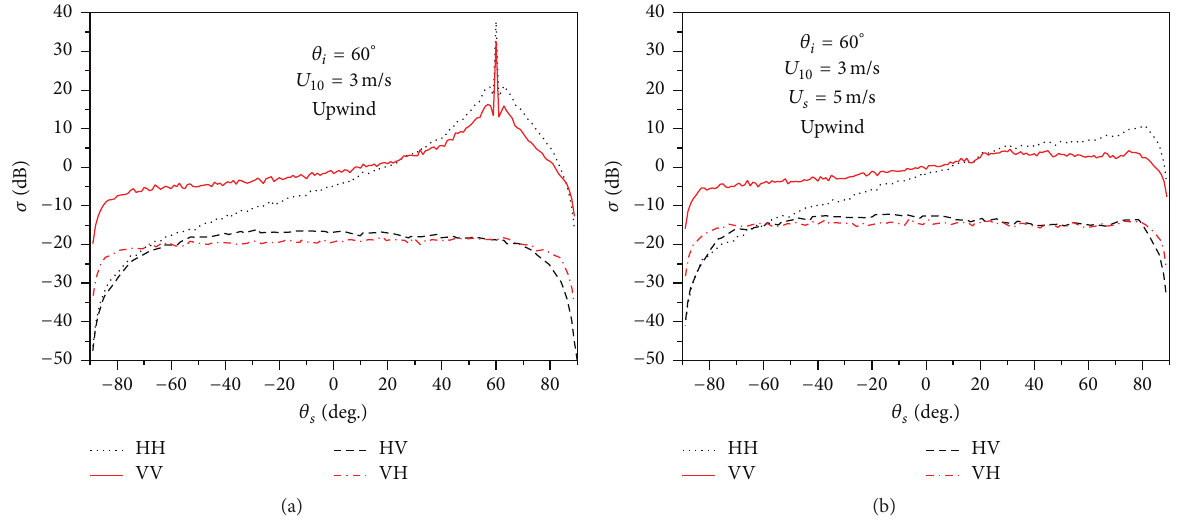
Figure 13: Similar to Figure 12, but with incident angle 𝜃 𝑖 = 60 ∘ . (a) Sea alone and (b) sea with